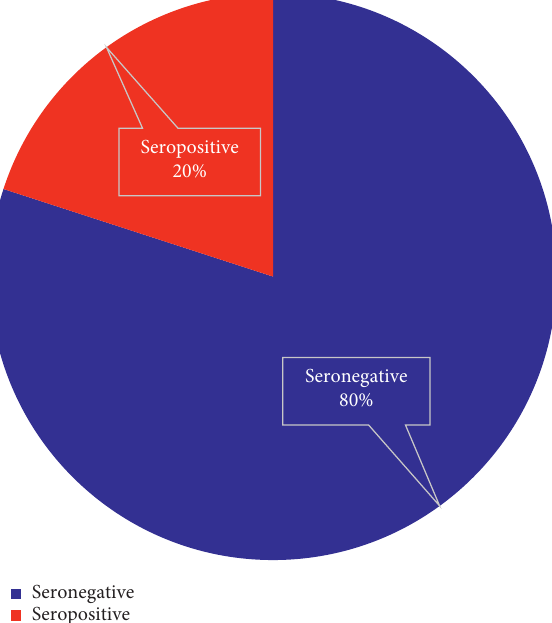
Figure 2: The proportion of tested male partners seropositivity status at JUSH ( N �